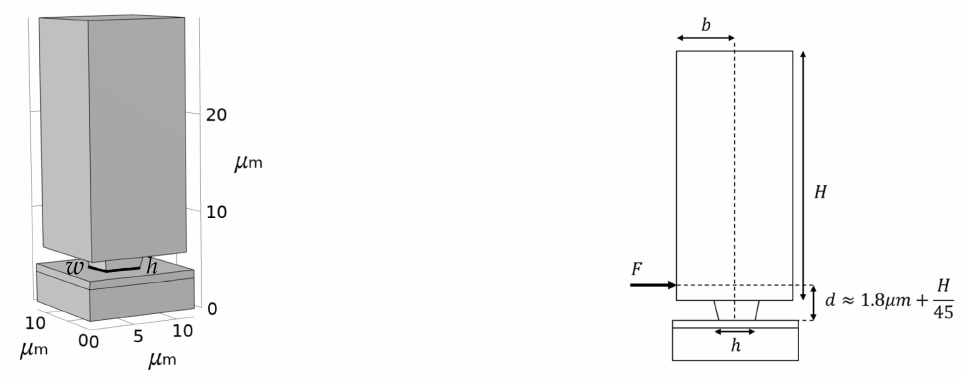
Figure 3. Stopper geometry and (distributed) contact force induced by the shuttle